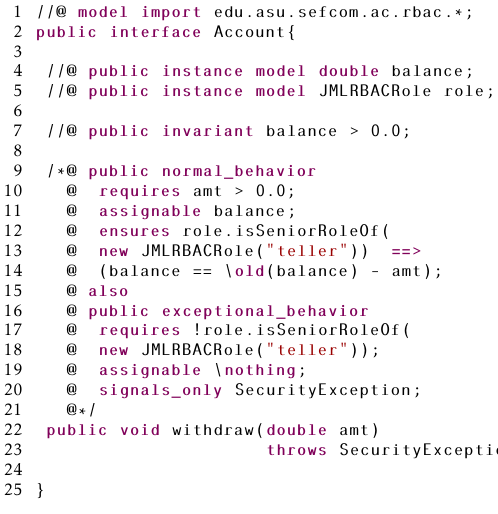
Figure 7. Enhancing a DBC contract with Access Control Assertions.